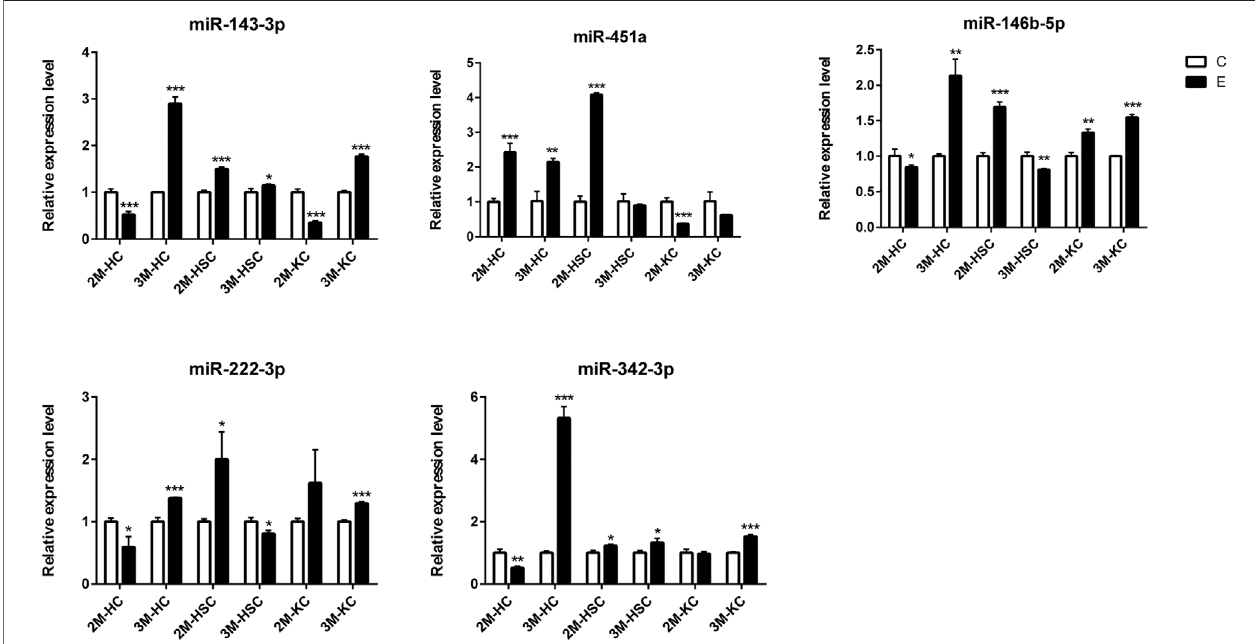
FIGURE 6 | The relative expression levels of5 miRNAs in 2M-HC, 3M-HC, 2M-HSC, 3M-HSC, 2M-KC and 3M-KC were determined by qRT-PCR. The number of biological replicates for each experiment was 3 and the relative expression levels were normalized to the expression levels of U6. Data are presented as means with SD. p -values were analyzed by Student ’ s t -test. *** p < 0.001, ** p < 0.01 and * p < 0.05.